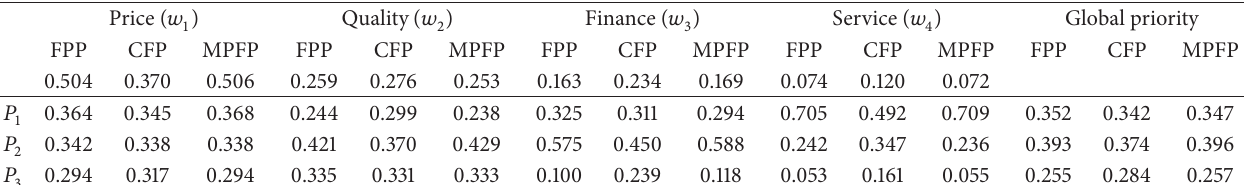
Table 3: Decision table of FPP, CFP, and proposed MPFP methods (Example 1).